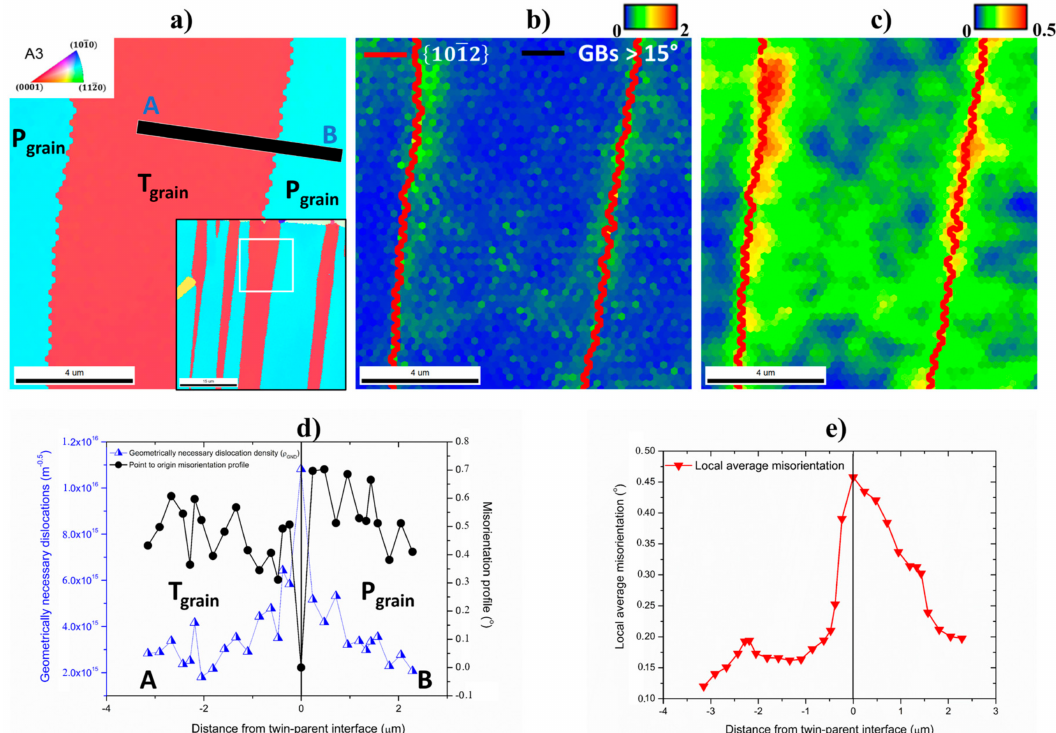
Figure 4. ( a ) Inverse pole figure (IPF) map of twin lamellae intersecting a grain boundary; inset image shows a low magnification IPF map enclosing the area of interest highlighted in black square. Slit orientation between points A and B is shown schematically; parent and twin grains are labelled as P grain and T grain ; (cid:8) (cid:9)(cid:10) (cid:11) 1012 ( b ) KAM and ( c ) LAM maps ( 1011 tension twin boundaries shown in red and high angle grain boundaries shown in black); ( d ) GND density and misorientation profile (with respect to the grain boundary) inside twin and neighbor grain; and ( e ) LAM profile between points A and